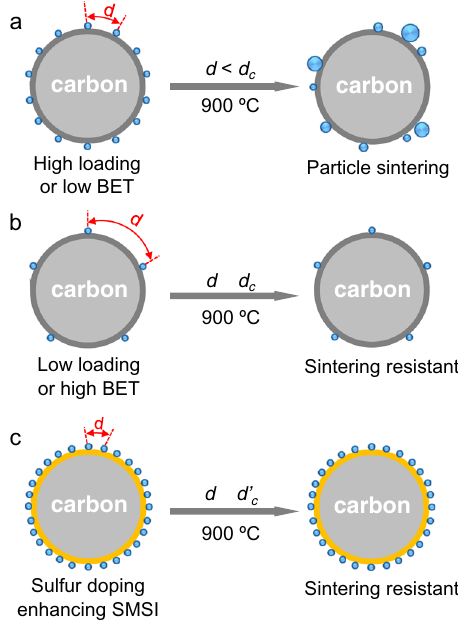
Fig. 1 Schematic illustration of mitigating sintering by controlling particle distance. a High metal loading or use of low-surface-area supports results in a shorter particle distance than the critical distance (that is, d < d c ), leading to severe sintering. b Enlarging the particle distance to above d c (that is, d ≥ d c ) by lowering metal loading or using high-surface-area supports results in sintering-resistant catalysts. c Strengthening the interaction between metal and carbon supports by sulfur doping can shorten the critical particle distance and thus achieve sintering-resistant catalysts with high metal